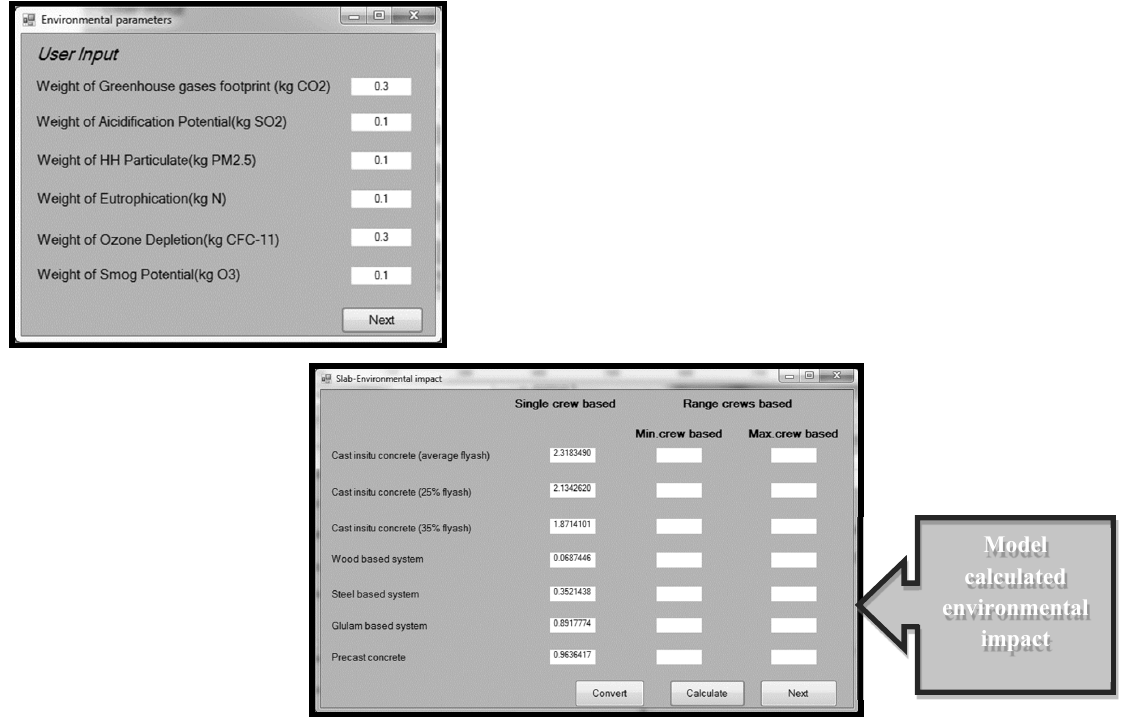
Fig. 6. Calculated environmental impact of the developed